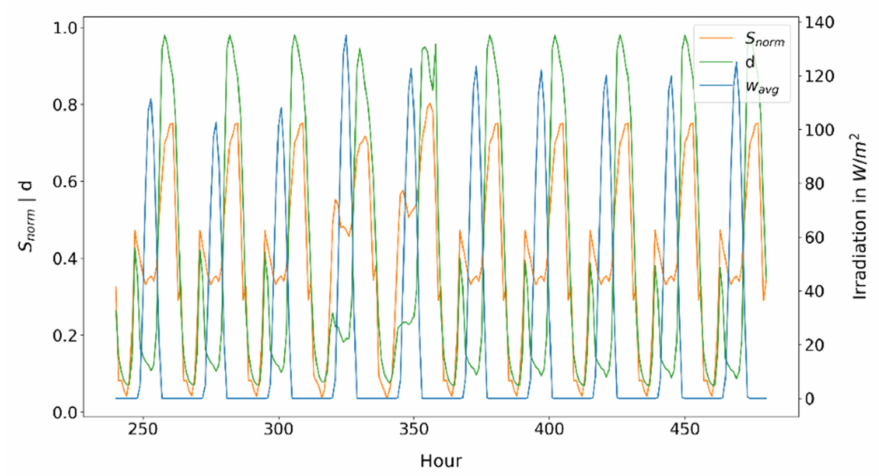
Figure A3. Example of training data for the device lighting. The plot shows an excerpt of 10 days in January. We train the neural networks to predict d from S norm and w avg and, therefore, correlate consumption data with input data that are comprehensively available. In this case of lighting, d is less dependent on S norm and strongly dependent on w avg .